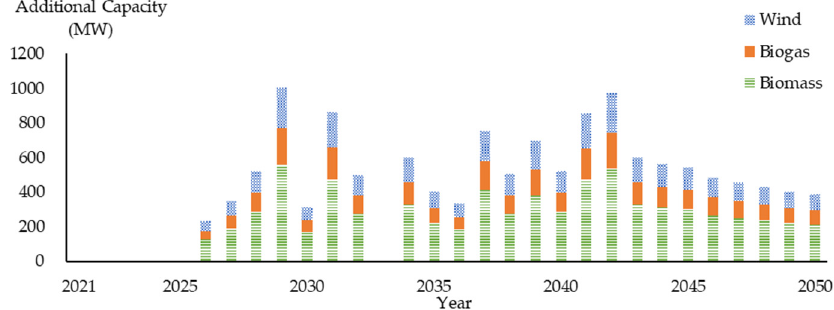
Figure 5. Additional renewable energy capacity.